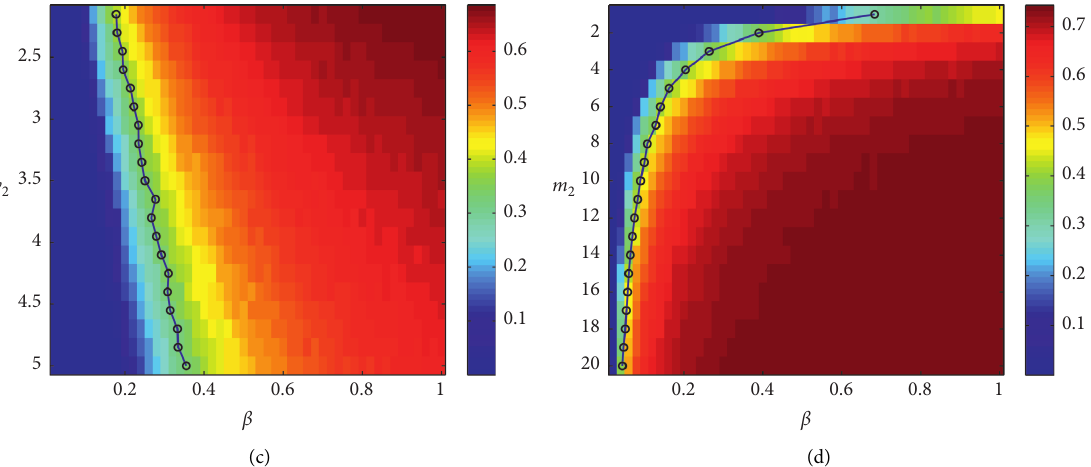
Figure 7: The heat maps of ρ c m c and m are approximately uncorrelated i and β (a–c) and i and β (b–d). (a, b) I as a function of a pair of 1 1 with the outbreak threshold and effectively affect the spread of disease, which suggests that the dynamic social relationships of individuals in the resource layer cannot inhibit the outbreak of the disease but can effectively suppress the spreading of disease. (c, d) c and m 2 2 significantly affect the outbreak threshold and the spread of disease, which suggests that the dynamic physical contacts of individuals in the epidemic layer have strong influences on the dynamic process of epidemic spreading. The other fixed parameters are δ � 0.10, λ � 0.64, � 5 for (a), (c), and (d); m � 5 for (a), (b), and (c); c � 2.5 for (b), (c), and (d); and c � 2.5 for (a), (b), and μ � 0.48, and m 1 2 1 2